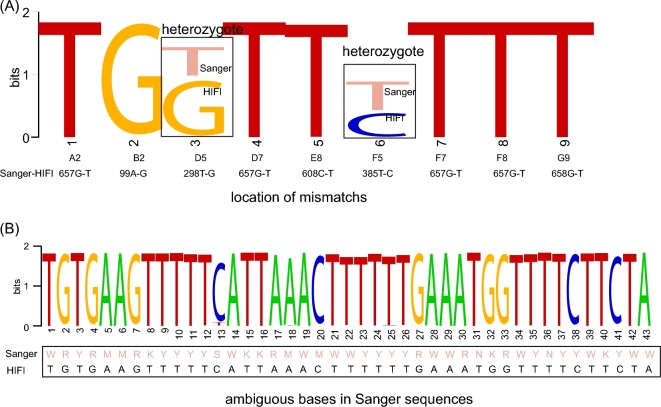
Discrepancies between Sanger and HIFI-Barcodes in the first plate. Entropy weight was calculated based on the strength of read depth by aligning Illumina raw reads onto assembled HIFI-Barcodes, showing potential heteroplasmy (A) and differences between ambiguous Sanger base-calling and specific nucleotide identified in HIFI-Barcodes (B).